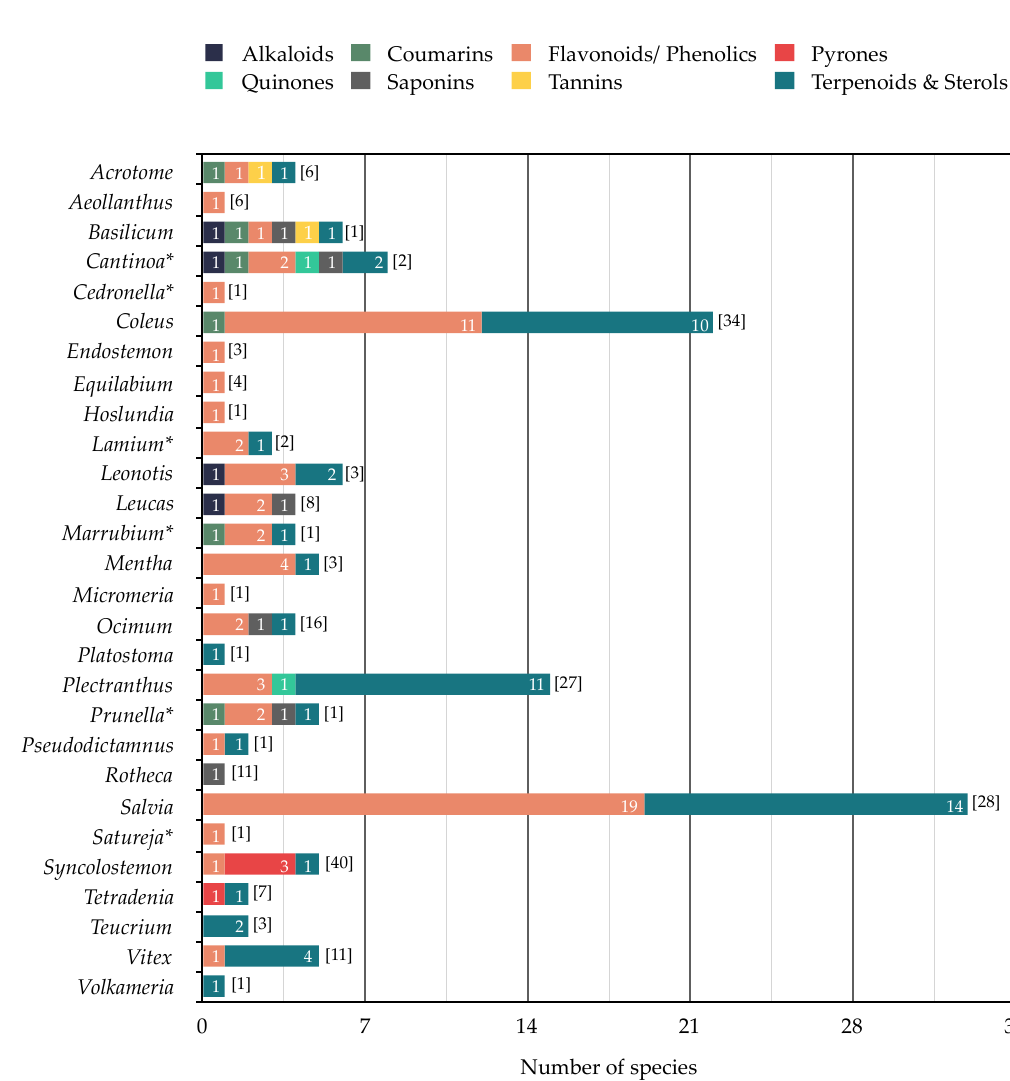
Figure 5. The numbers of species from 28 genera (out of 42) of southern African Lamiaceae that have been subjected to phytochemical studies, and the classes of non-volatile compounds that have been reported (total number of species per genus is shown in square brackets; essential oil studies are shown in Figure 4).